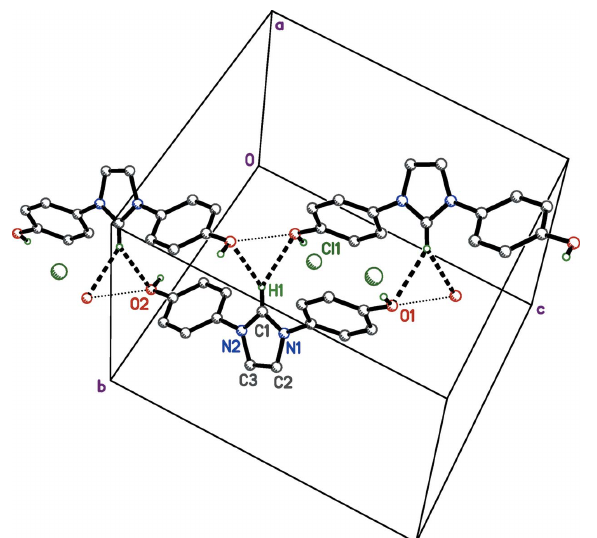
Figure 4 A plot showing the bifurcated C—H (cid:2)(cid:2)(cid:2) O interactions (dashed solid lines) and O (cid:2)(cid:2)(cid:2) O close contacts (dotted lines) in crystalline IOH (cid:2) Cl. The unlabelled molecules are related to the partially labelled molecule by inversion [upper left: ( (cid:3) x , (cid:3) y + 1, (cid:3) z ); upper right: ( (cid:3) x + 1, (cid:3) y + 1, (cid:3) z + 1)]. H (cid:2) (cid:2) (cid:2) O interactions occur between imidazole ring atoms (C1— H1) and hydroxy O atoms (O1 i and O2 iii ) on molecules related by different inversion centres. These same hydroxy O atoms are in close contact with each other, i.e. O1 i (cid:2) (cid:2) (cid:2) O2 iii = 2.999 (3) A˚ [symmetry codes: (i) (cid:3) x + 1, (cid:3) y + 1, (cid:3) z + 1; (iii) (cid:3) x , (cid:3) y + 1, (cid:3) z ; Fig. 4]. In addition to hydrogen bonding, there are offset (cid:3) – (cid:3) stacking interactions (Fig. 5). The perpendicular